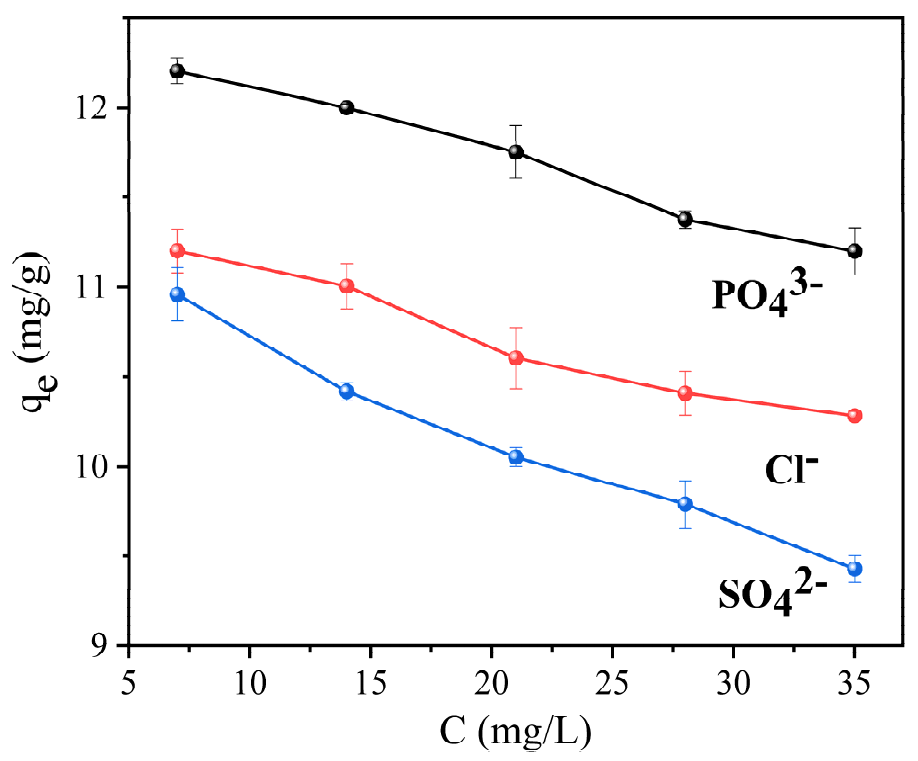
Figure 11. Adsorption effect diagram of MCM-48-SH under the three different coexisting ions in solution (the reaction temperature was 25 ◦ C, the amount of adsorbent was 25 mg, the pH of the solution was 2, and the reaction time was 3